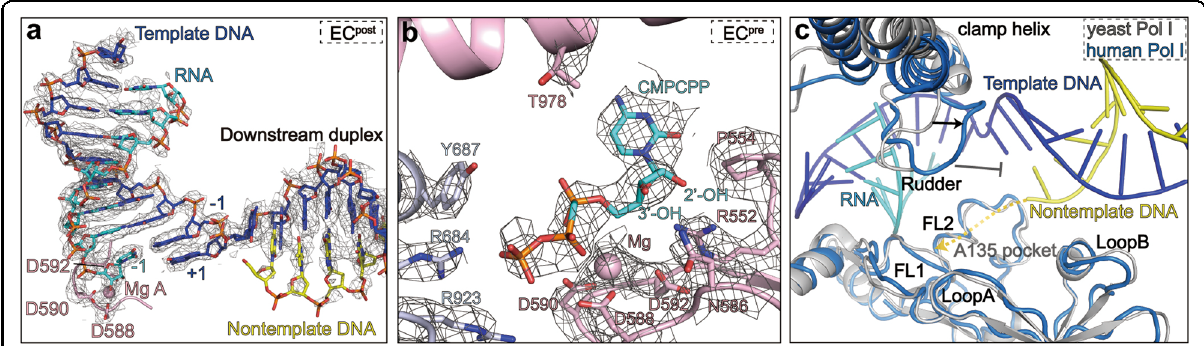
Fig. 3 The catalytic center of Pol I in the post- and pre-translocation states. a Cryo-EM map and structural model of the DNA – RNA hybrid in the Pol I EC post . Critical residues involved in catalysis are shown in sticks. The magnesium cation in the metal A position is shown in pink ball. b Close-up view of the catalytic center of Pol I EC pre . The cryo-EM map is shown in mesh and critical residues are shown in sticks. c Conformational differences of hPol I (marine) and yPol I (gray) around the transcription fork. The yellow dash line indicates the putative path of the nontemplate